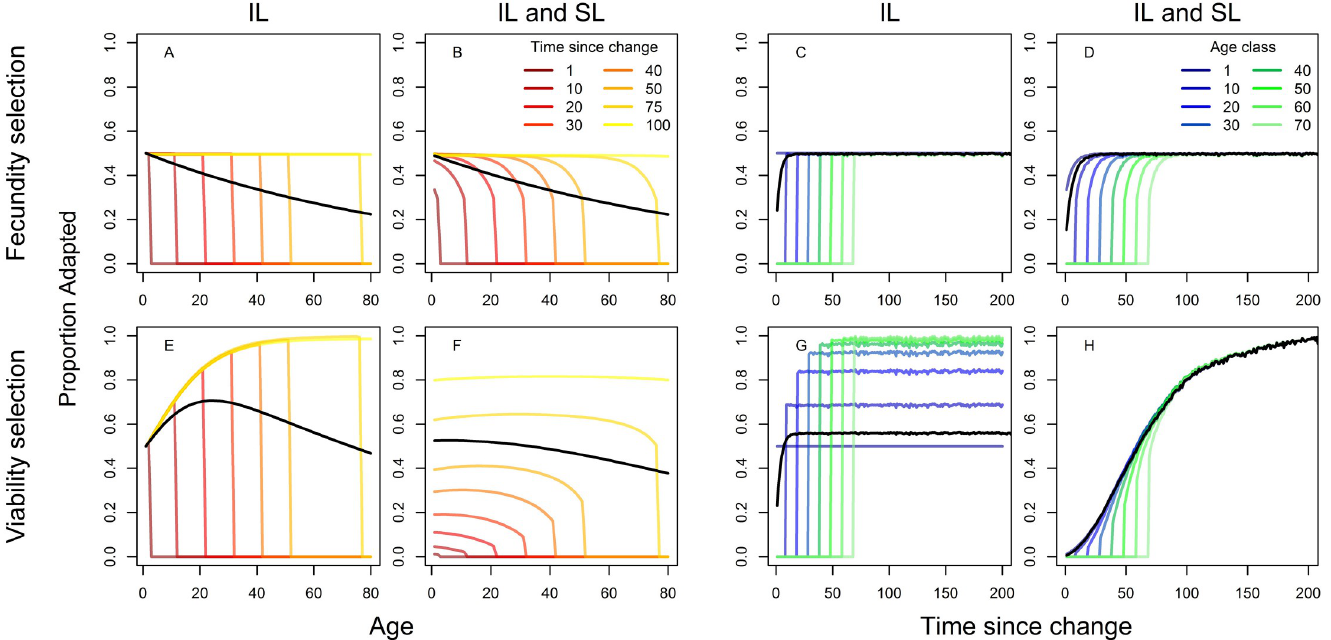
Fig 2. Proportion of adapted individuals per age class (left) and for different time intervals after an environmental change (right). Dynamics under fecundity selection (i.e., without demographic filtering) are shown on the top, dynamics under viability selection (i.e., with demographic filtering) are shown on the bottom. Comparison of populations with only individual learners (IL) and populations comprising both individual and social learners (IL and SL). Black solid lines represent averages. Results are shown for a z = 0.5 success rate of individual learning. Other parameter values were chosen to keep fitness constant at λ � 1.2 across different scenarios: u = 0.01, c = 0.01, ϕ = 1, b 0 = 0.35, b 1 = 0.5 (for fecundity selection), s 0 = 0.85, s 1 = 0.93 (for viability selection).